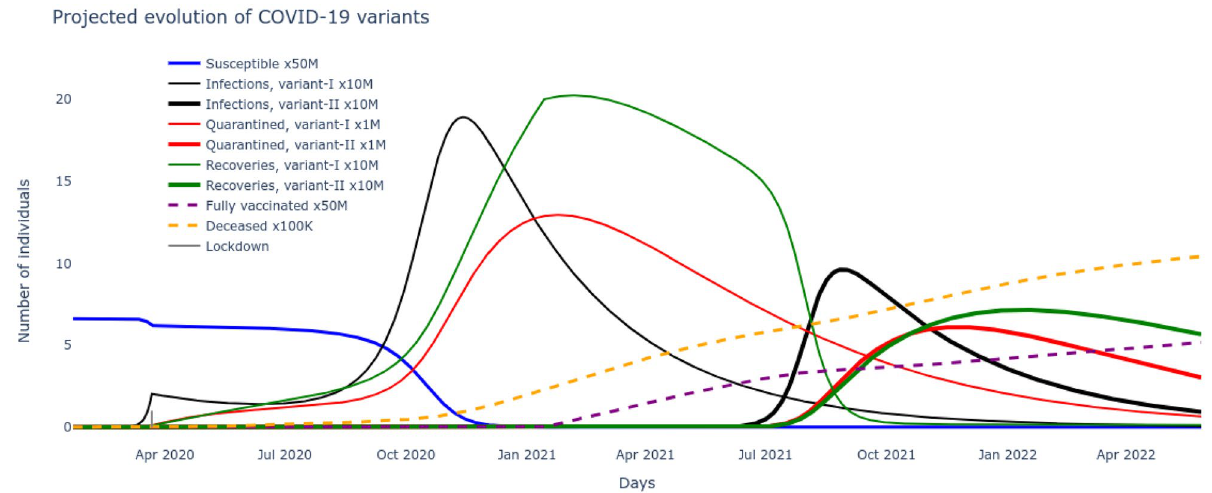
Figure 6. The optimized SI 2 Q 2 R 2 VD system projections reveal the evolution of the variant-driven